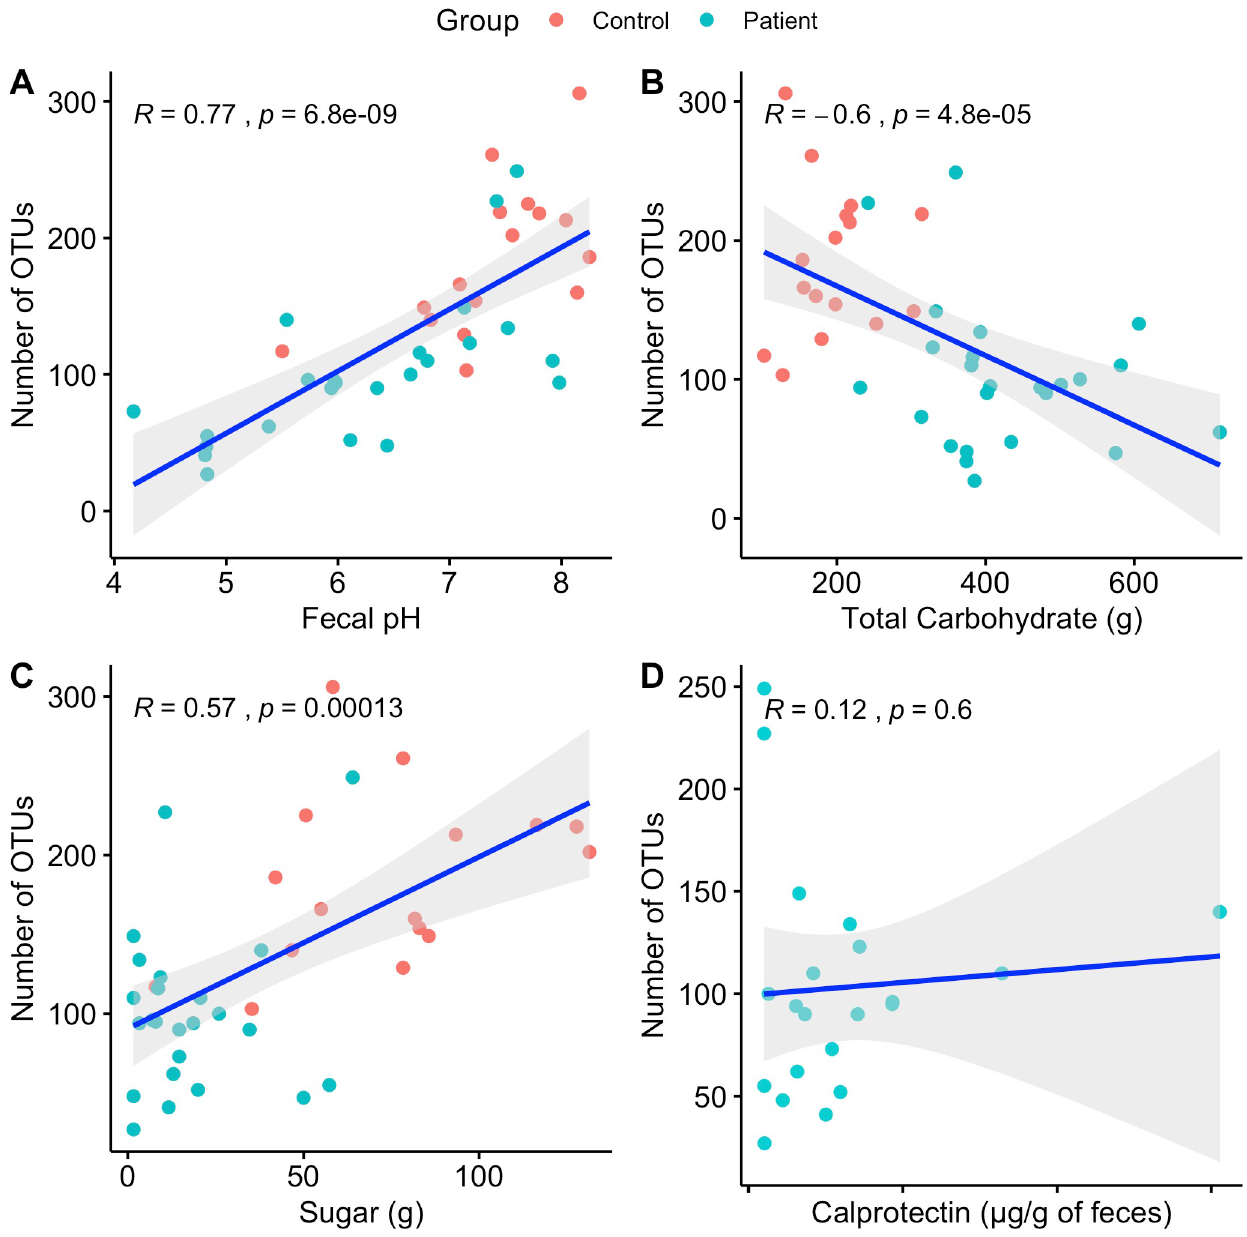
Fig 4. Correlations between the microbiota and diet, faecal pH, and gut